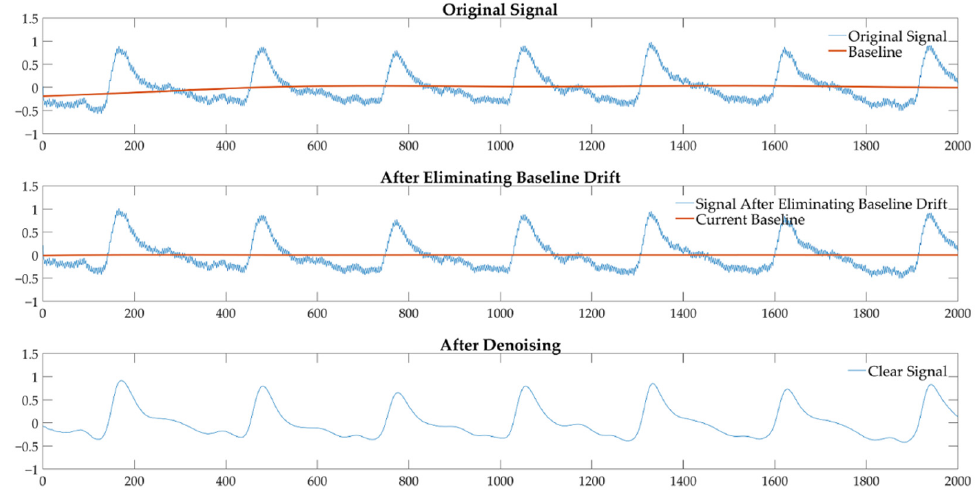
Figure 4. An example of simulated physiological recordings using the preprocessing methods.